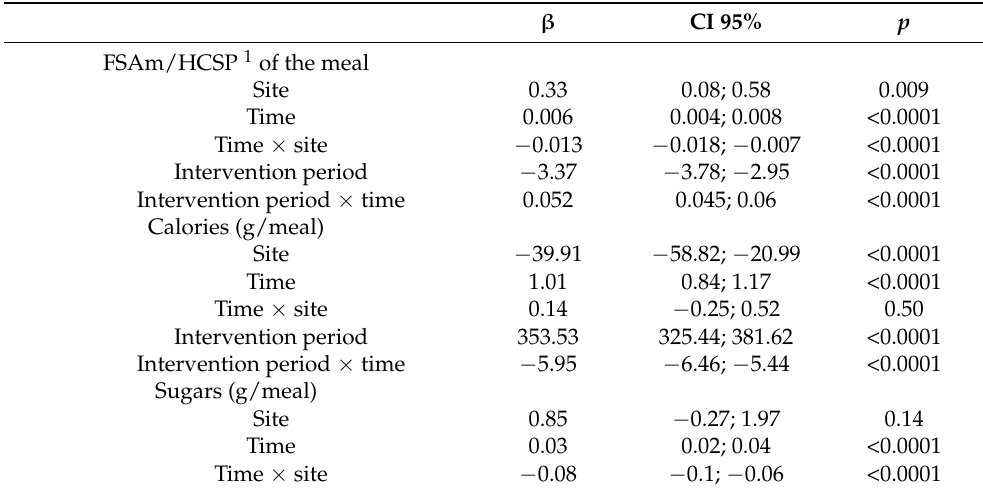
Table 3. Impact of the Nutri-Score on the overall nutritional quality of meals and nutrient intake over time—Nutri-Score catering